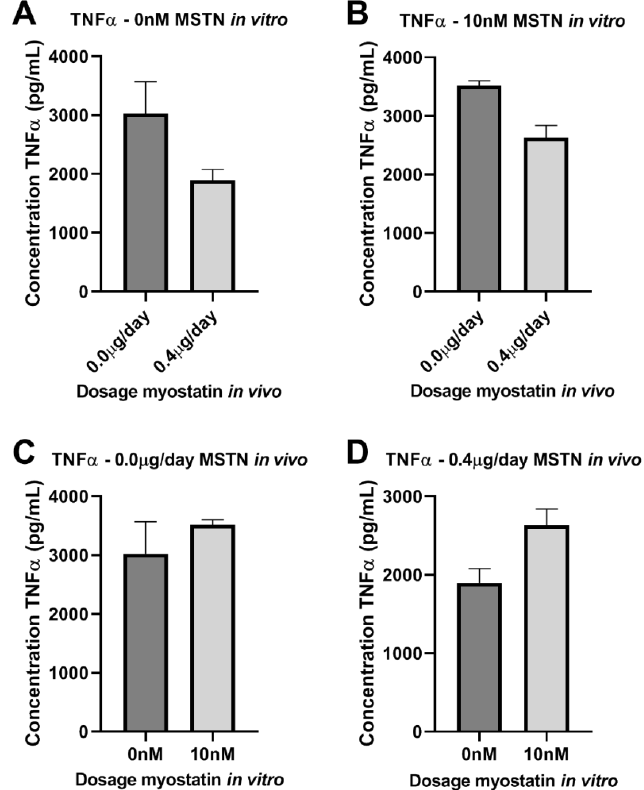
Figure 7. A – E : Effect of myostatin on macrophages. A–D— TNFα in supernatant of bone marrow macrophages stimulated with myostatin. A,B —in vivo treated mice with 0.0 vs. 0.4µg myostatin/day and not treated in vitro with myostatin ( A ) or in vitro treated with 10 nM myostatin ( B ) did not show significant differences. C,D —in vivo not treated ( C ) or treated ( D ) and in vitro not treated or treated with myostatin did not show significant differences. Mean expression is shown as average of duplicate measurements of pooled cells and error bar represents SEM. Student’s t-test did not show significant differences.